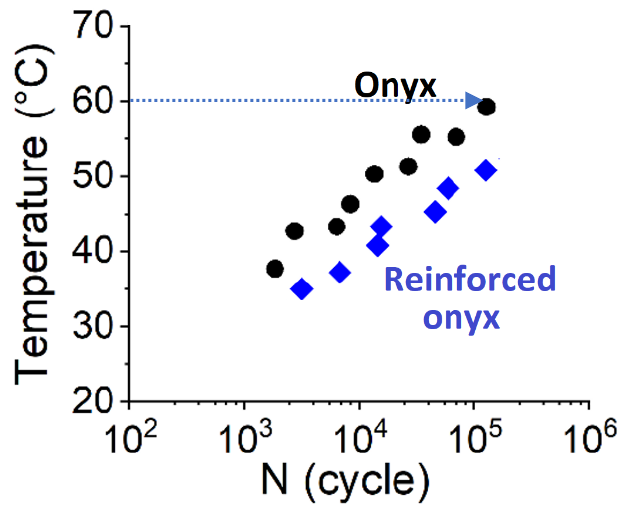
Figure 22. Evolution of the maximum induced temperature during the fatigue test [24].